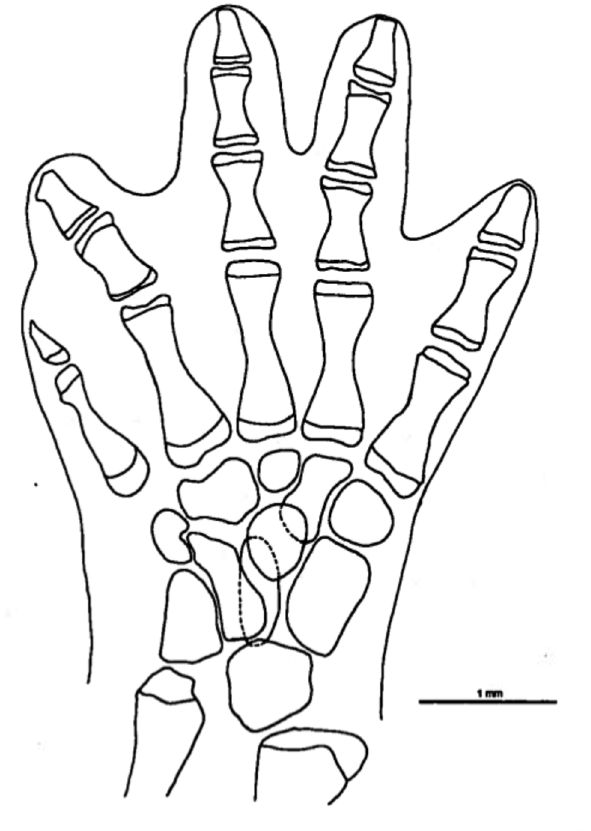
Fig 17. Anomalous Chiropterotriton priscus foot. Anomalous morphology of the right, hind foot of a single specimen of Chiropterotriton priscus (MVZ 138883). Dorsal view; distal tarsals